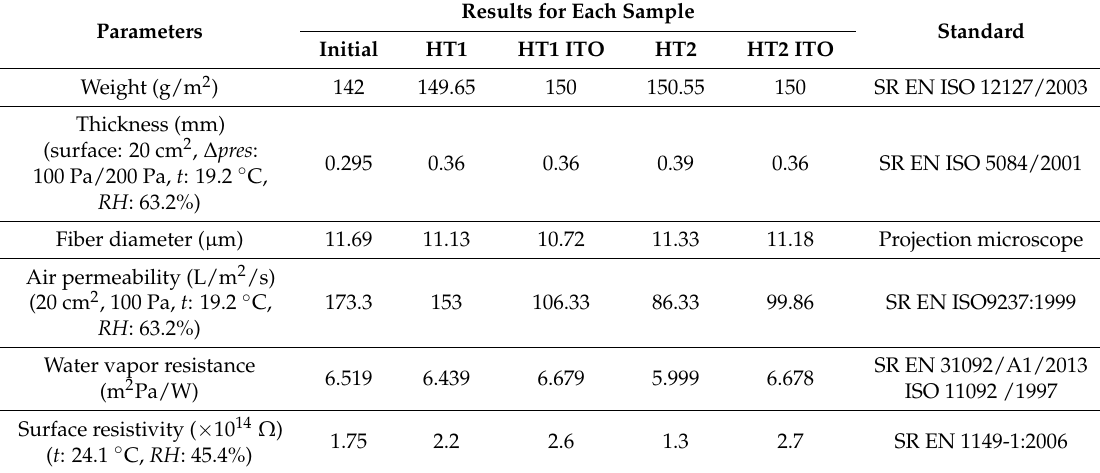
Fiber diameter ( µ m) Projection